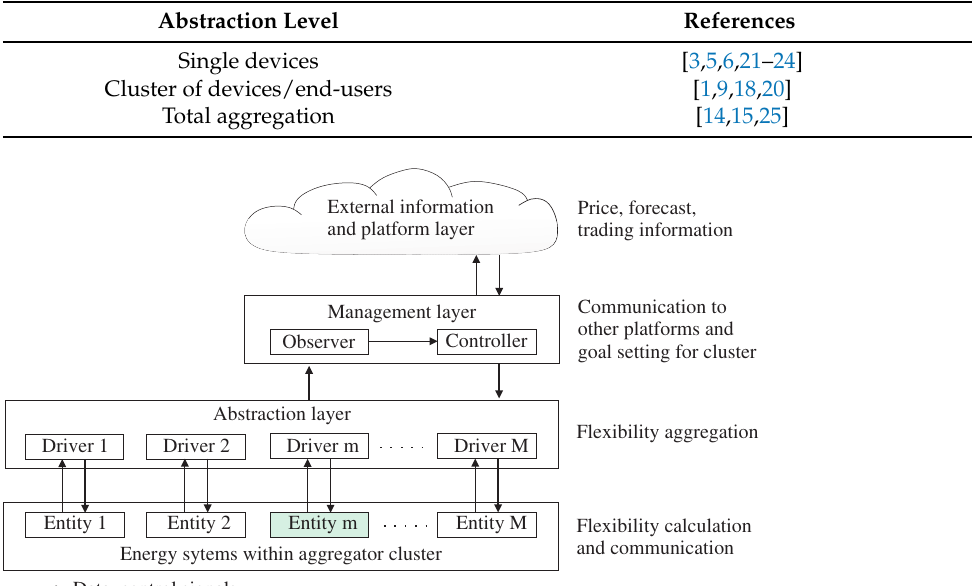
Figure 2. General architecture of data and control signal exchange between entities in aggregator systems and management